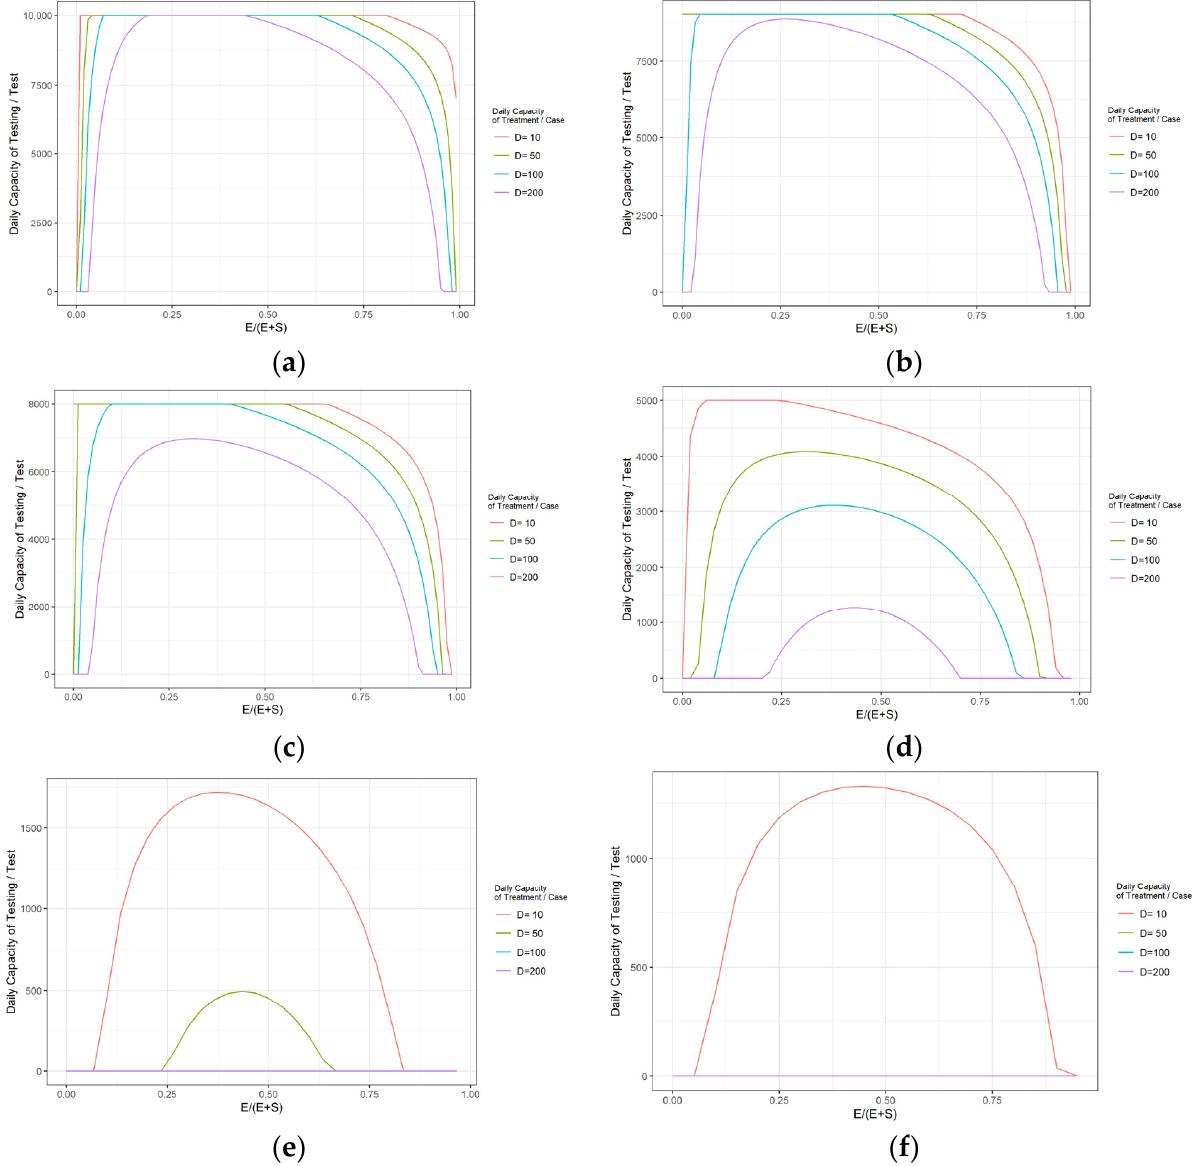
Figure 4. The effect of daily testing capacity on the ability to control the potential development level of the epidemic. ( a ) S + E = 9999, I = 0; ( b ) S + E = 9000, I = 1000; ( c ) S + E = 8000, I = 1000; ( d ) S + E = 5000, I = 1000; ( e ) S + E = 3000, I = 1000; ( f ) S + E = 2000, I = 1000.